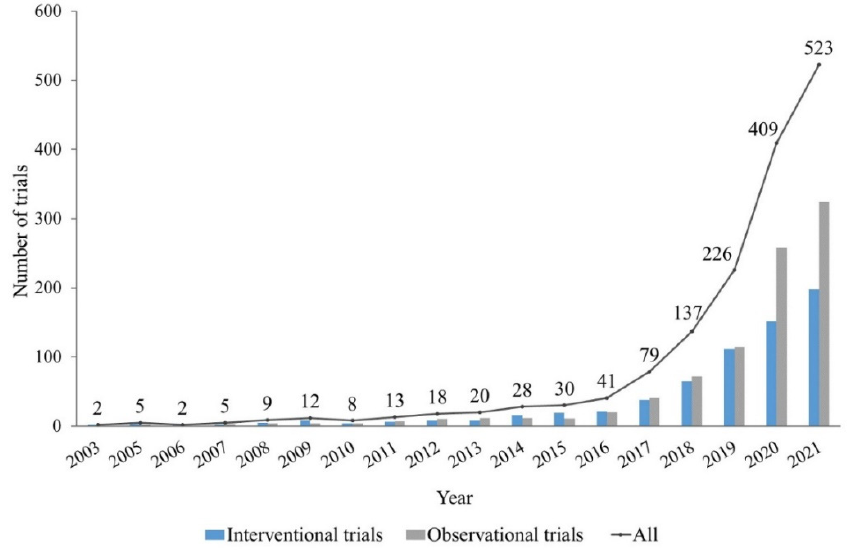
Figure 2. Distribution of AI-related trials according to the posted year on ClinicalTrials.gov ( n = 1725). Table 3. Characteristics of AI-related trials stratified by study